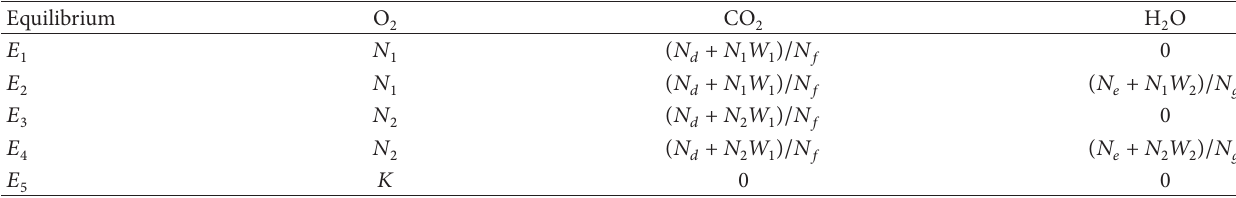
Table 1: Five equilibrium solutions to our system.